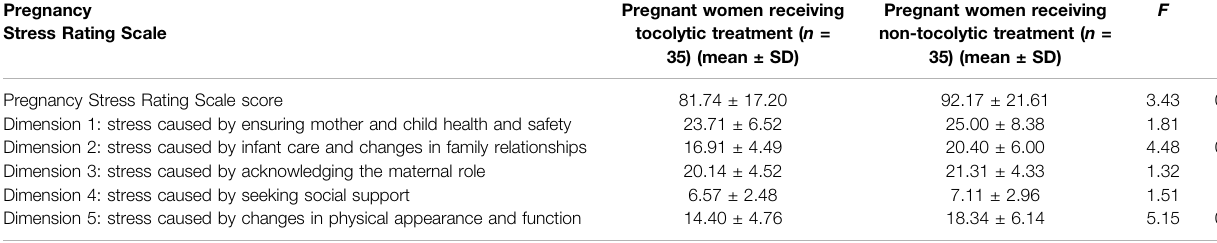
TABLE 3 | Comparison of pregnancy stress among pregnant women receiving tocolytic and non-tocolytic treatment where both used complementary medicine ( n = 70). Pregnancy Stress Rating Scale